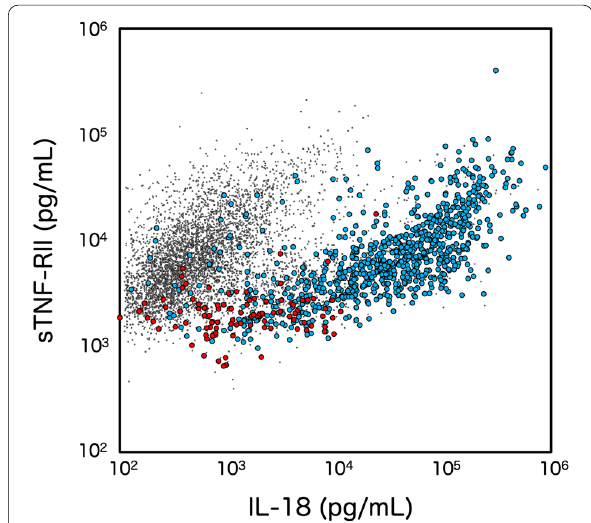
Fig. 4 Plot analysis of sTNF-RII and IL-18 in cases with febrile illness. 9140 serum samples from febrile patients were examined for 5 different inflammatory parameters as described in the legend for Fig. 3. Clea Plot analyses of sTNF-RII and IL-18 are shown in the figure. Small gray dots show the samples from all febrile illnesses. Blue circles indicate patients with sJIA or AOSD. Red circles show the patients with typical FMF